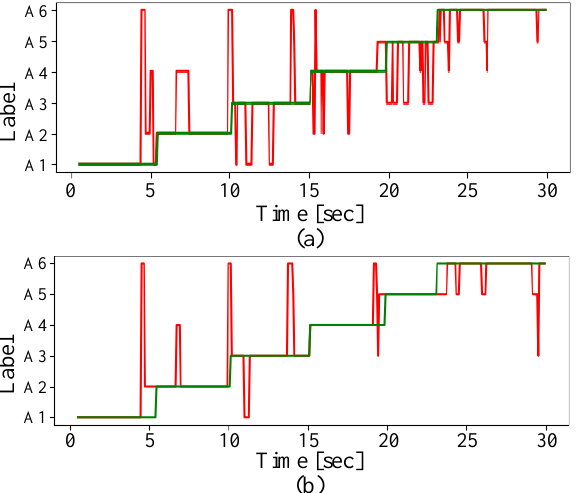
Figure 14. Comparison of ( a ) single-frequency Uni-LSTM prediction label and ( b ) parallelism Uni- LSTM with multi-frequency prediction label.